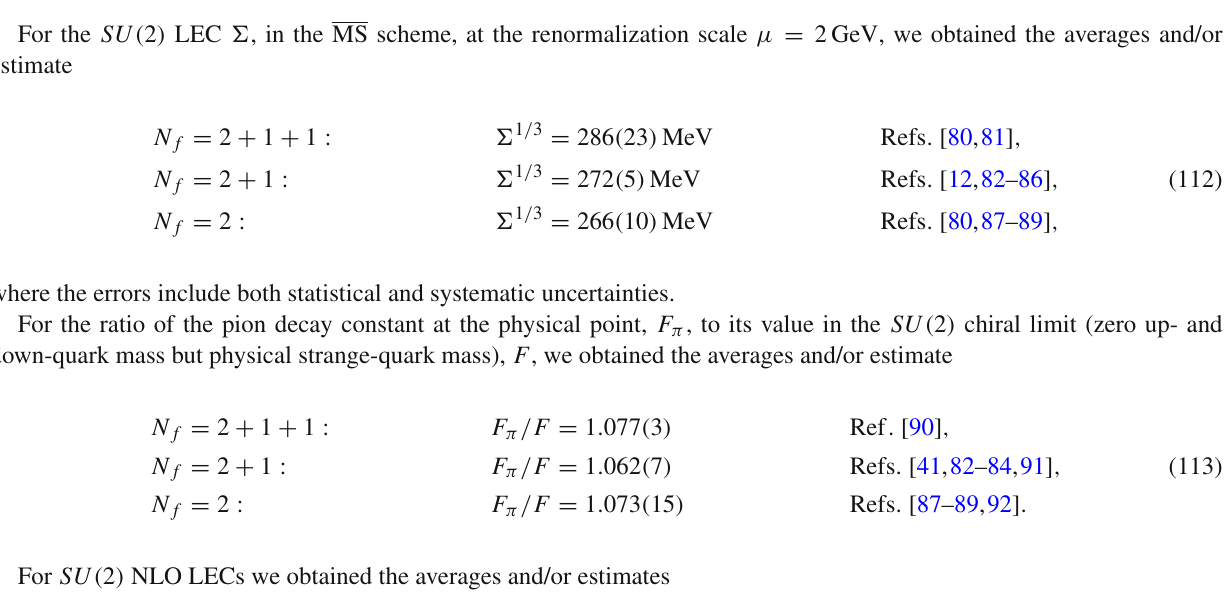
M π (top) and a 2 M π (bottom). Results in Table 25 with statistical error only are not 0 0